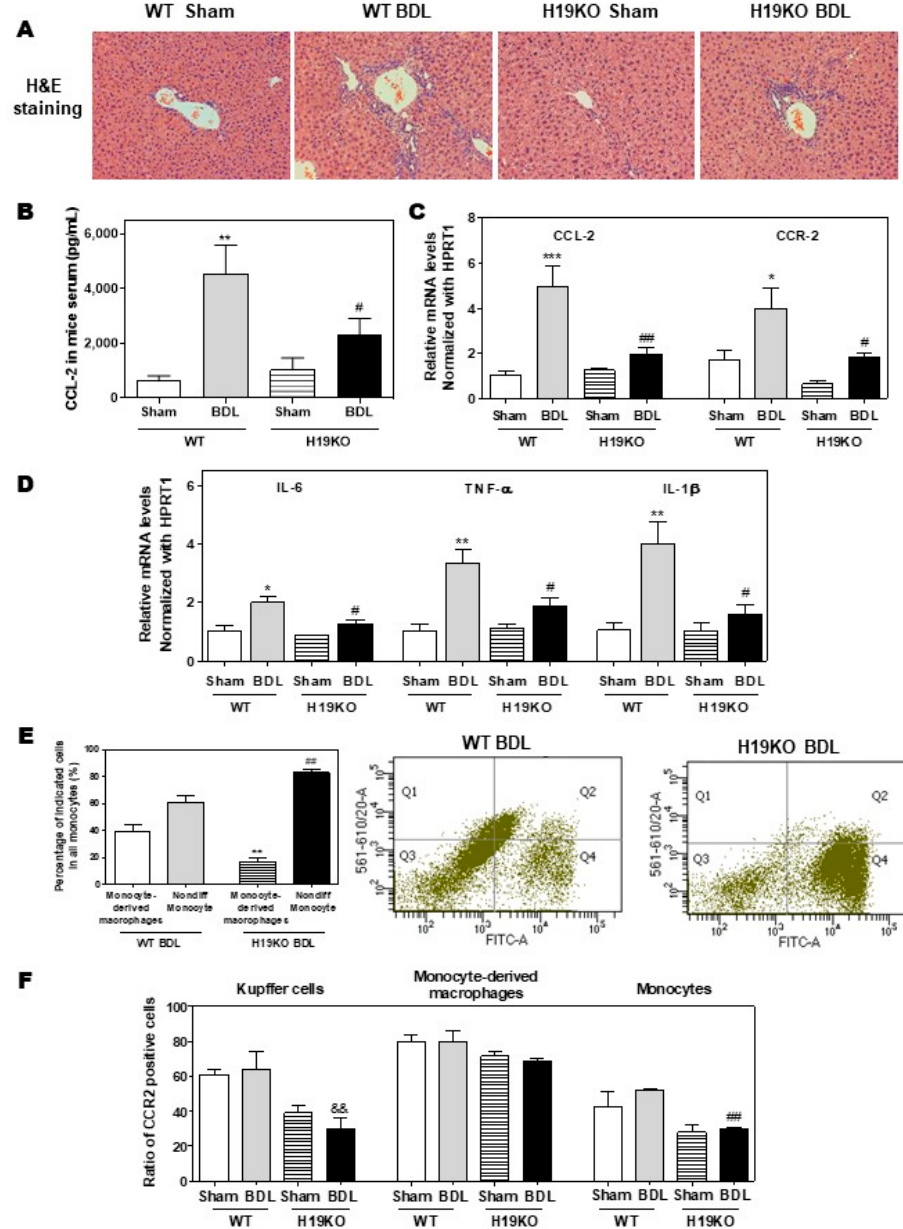
Figure 6. H19-enriched exosomes promote liver inflammation and macrophage activation in bile duct ligation (BDL) mice. Both WT and H19KO mice (both male and female at 12 weeks old) were subjected to sham operation or BDL for 2 weeks. ( A ) Representative images of H&E staining are shown. ( B ) CCL-2 levels in the serum. ( C , D ) The relative mRNA levels of hepatic CCL-2, CCR-2, IL-6, TNF- α , and IL-1 β were determined by real-time RT-PCR and normalized using HPRT1. Statistical significance: * p < 0.05, ** p < 0.01, *** p < 0.001, compared with WT sham mice; # p < 0.05, ## p < 0.01, compared with WT BDL mice ( n > 6). ( E , F ) Cell type-specific markers were used to determine the cell population using flow cytometry analysis. ( E ) Representative flow cytometry results and images of the percentage of indicated cells in all monocytes are shown. ( F ) The ratio of CCR-2 positive cells in Kup ff er cells, monocyte-derived macrophages, and monocytes. Statistical significance: ** p < 0.01, compared with monocyte-derived macrophages in WT BDL mice; ## p < 0.01, compared with non-di ff erentiated monocytes in WT BDL mice; && p < 0.01, compared with Kup ff er cells in WT BDL mice ( n >